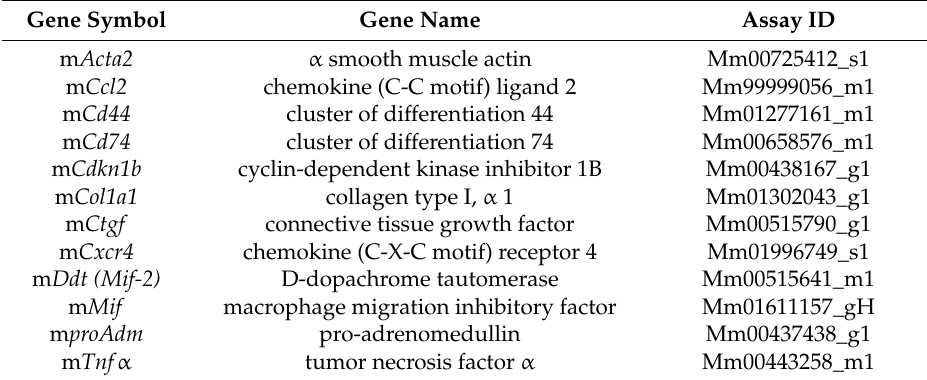
Table 2. Gene expression assays purchased from Life